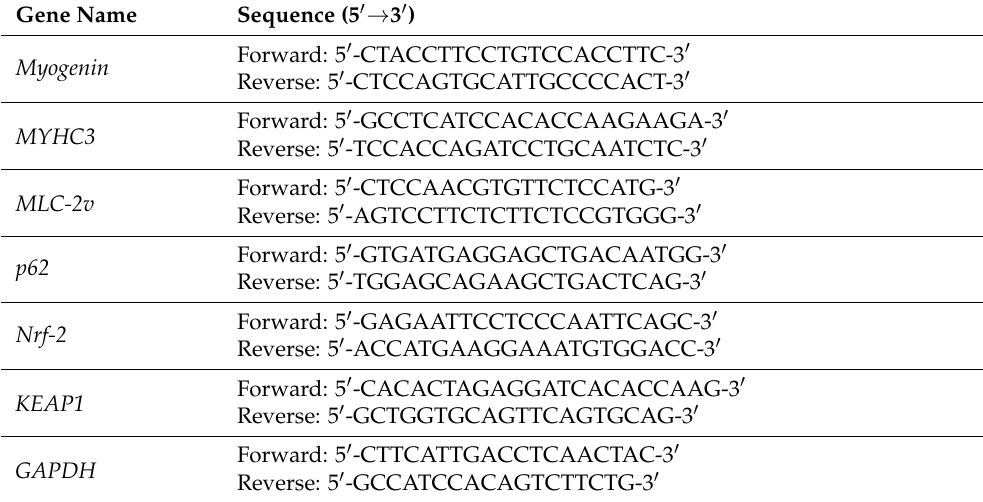
Table 2. PCR primers used for this